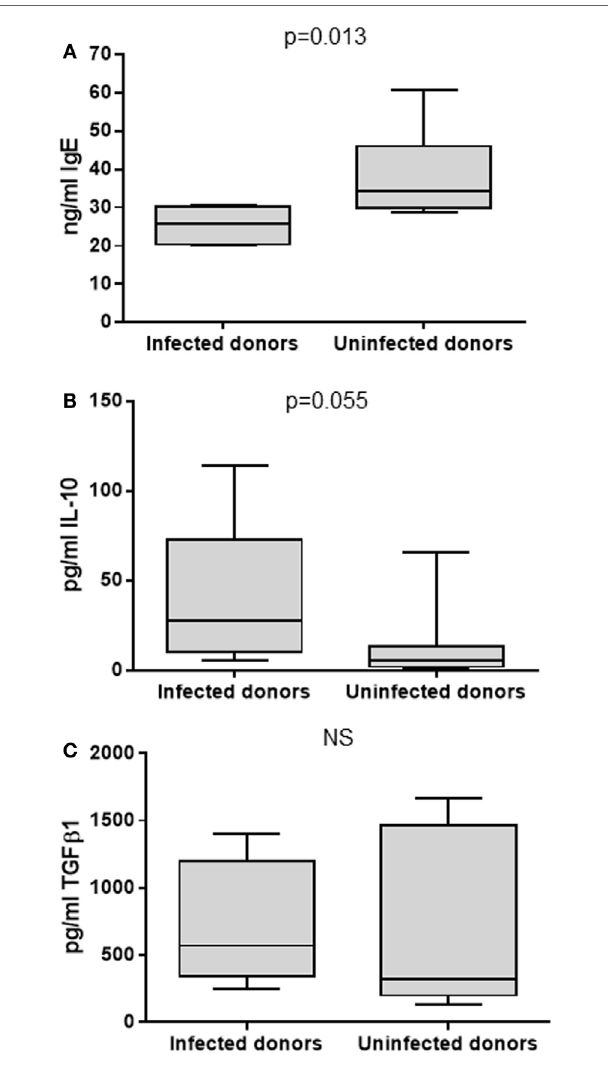
FigUre 6 | culture of PBMcs under Th2-skewing conditions . PBMCs from 5 infected and 10 uninfected donors were cultured for 12 days before assaying the supernatants for total IgE (a) , IL-10 (B) , and TGF β 1 (c) by ELISA. NS = no significant